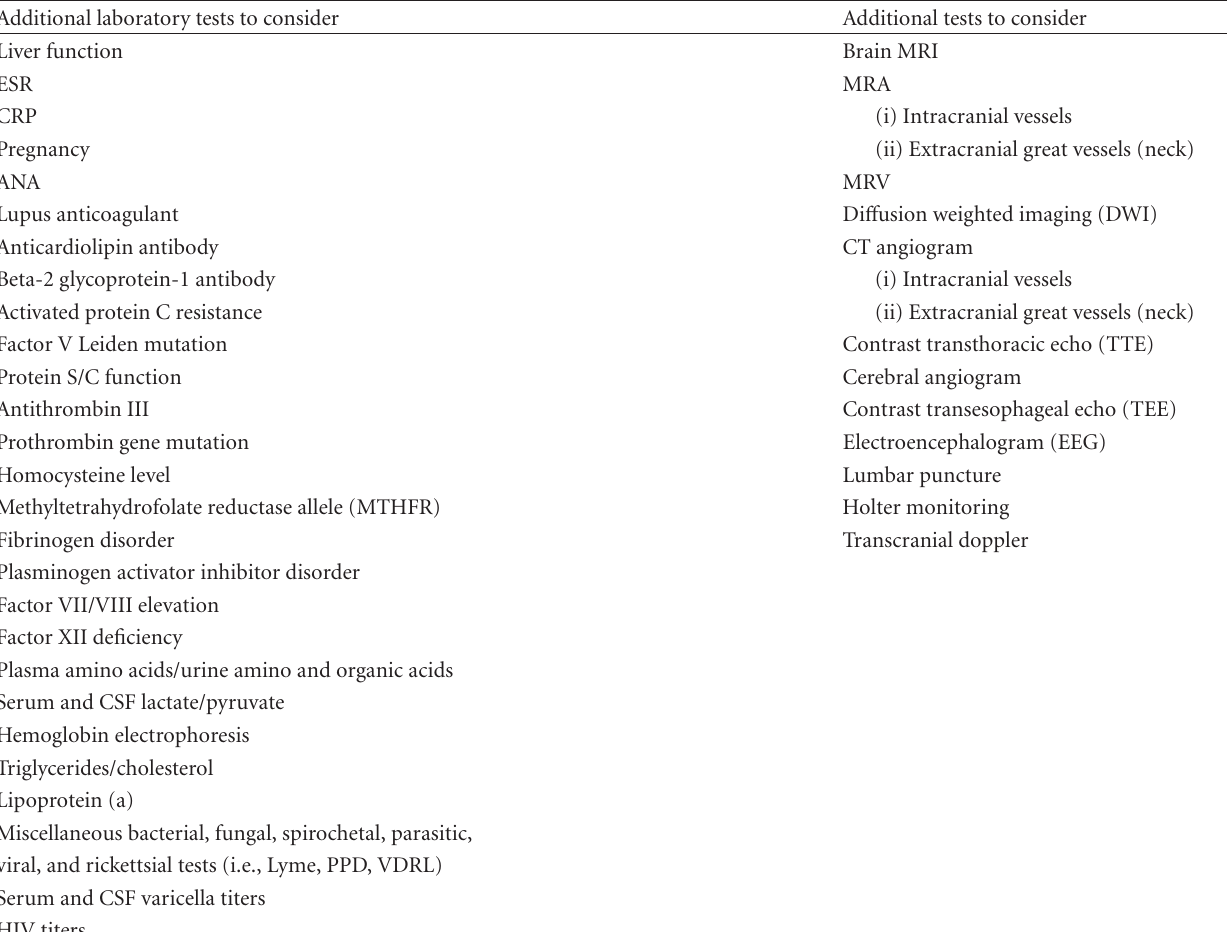
Table 2: Laboratory and diagnostic testing considerations for the acute pediatric stroke